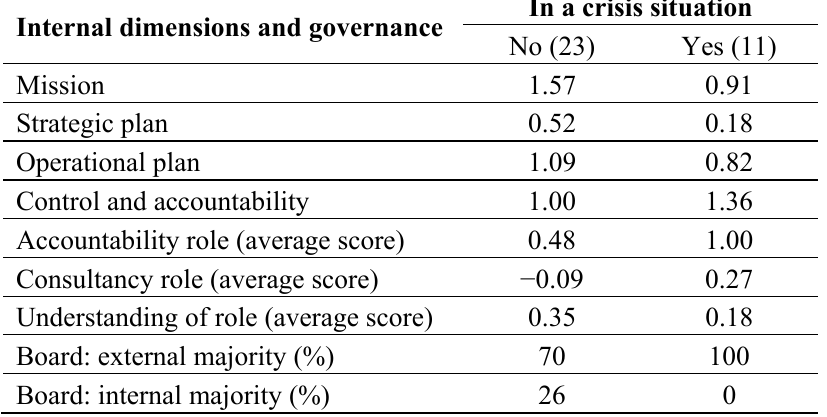
Table 12. Internal dimensions and governance when in crisis/not in crisis (average